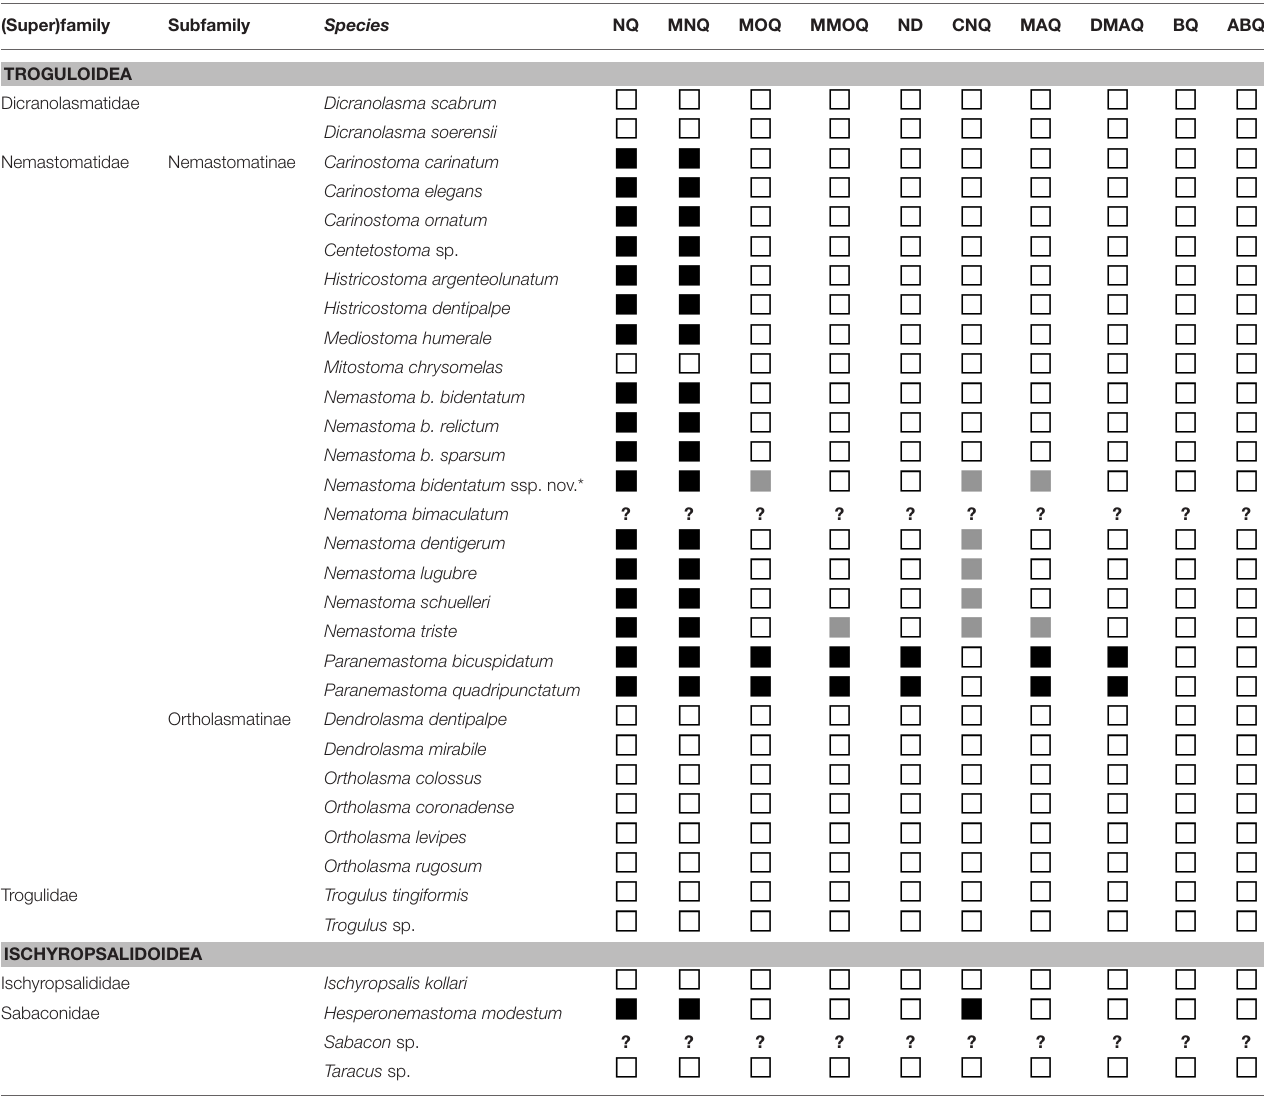
TABLE 3 | Naphtho- and benzoquinone distribution across the secretions of Dyspnoi.